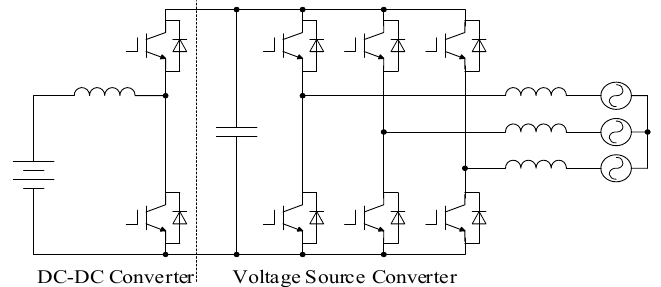
Figure 1. System topology of the conventional two-stage VSC-BESS.